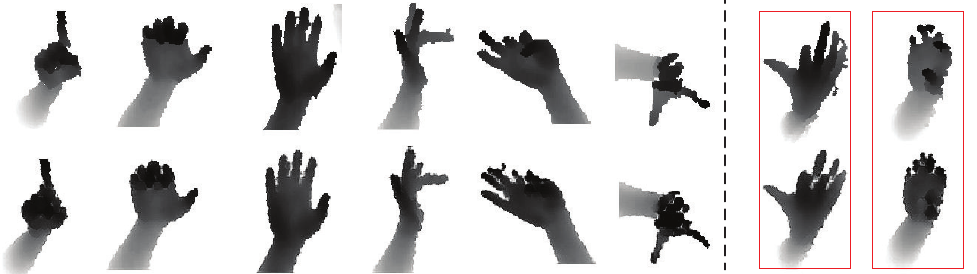
Figure 8. Samples generated by the GAN and style-transfer network for different poses from the test set. Top: Ground-truth depth image. Bottom: Synthetic depth image using our learned hand model. (Best viewed on